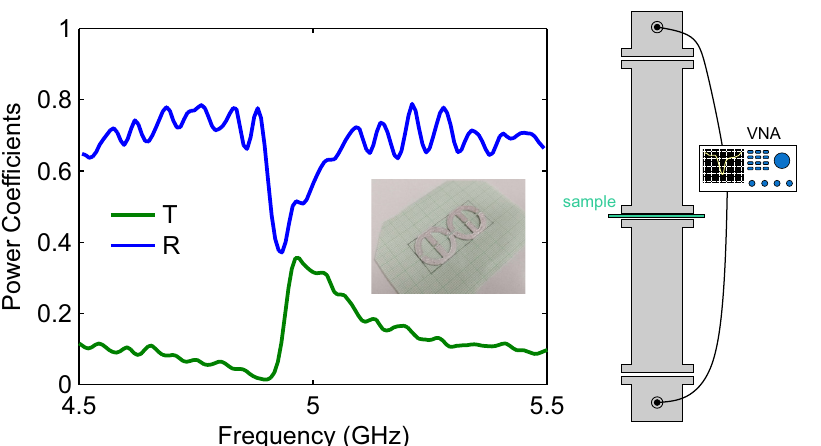
Figure 5. Measurement of the 3D-printed conductive unit cells within the WR-187 rectangular waveguide. The reflection ( R = | S 11 | 2 ) and transmission ( T = | S 21 | 2 ) power coefficients are plotted in the frequency range of 4.5–5.5